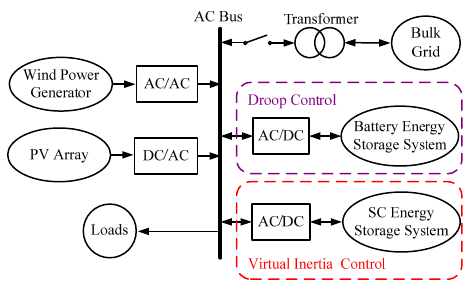
Figure 1. AC microgrid with HESS.